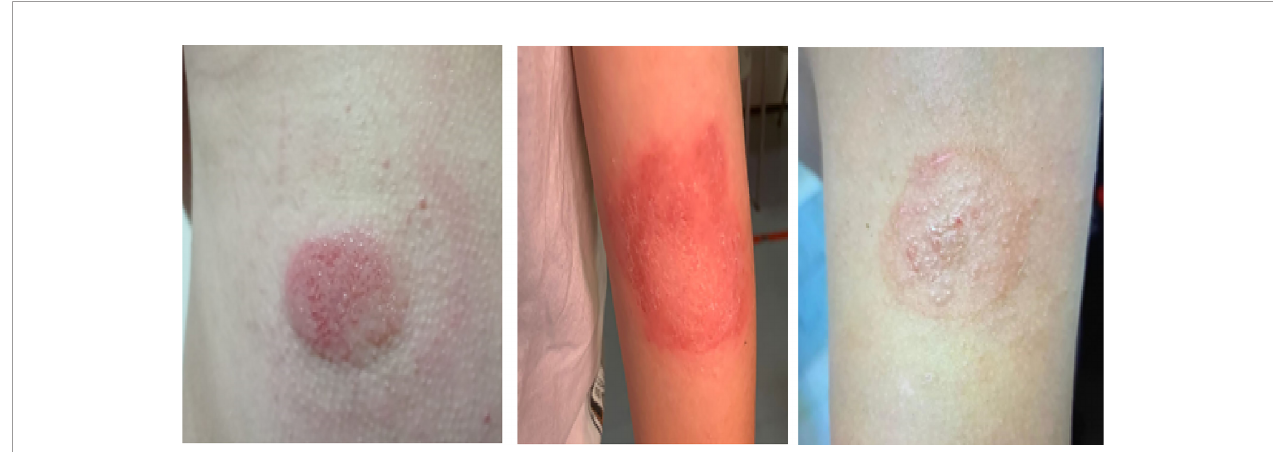
FIGURE 1 | Three cases of contact dermatitis caused by adhesives contained in continuous glucose monitoring